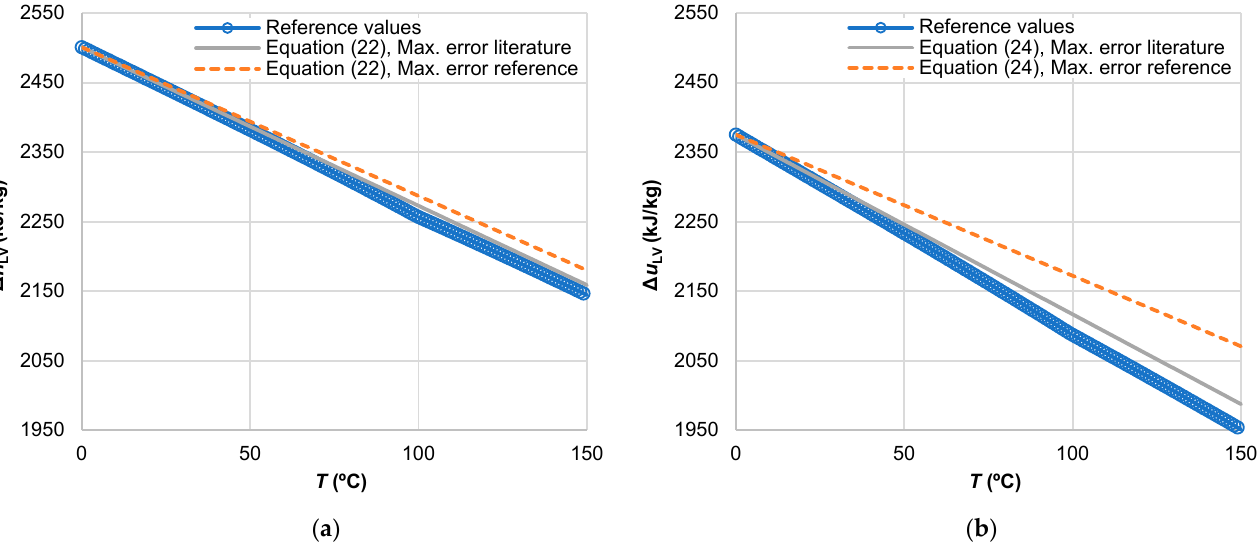
Figure 7. Values of ( a ) Δ h LV and ( b ) Δ u LV computed with Equations (22) and (24), respectively, for specific heat capacity pairs that maximise error, from the literature (solid grey lines, values from [12,14], Δ h LV , and [17], Δ u LV ) and from reference values (dashed orange lines). Reference Δ h LV and Δ u LV [13] in blue markers.